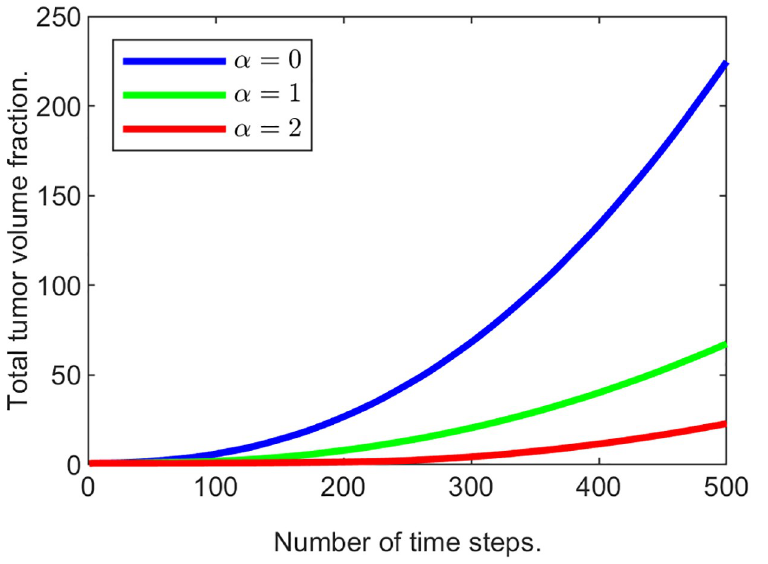
Fig 18. Tumor mass changing with time for various α with “passive” response turned off.